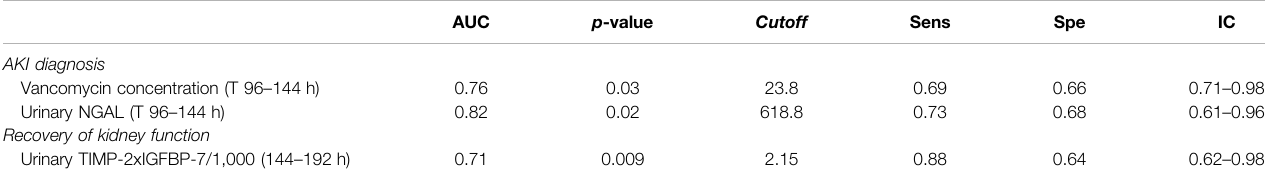
TABLE 9 | Sensitivity, speci fi city, area under curve, cutoff values of urinary biomarkers, and vancomycin concentration as predictors of diagnosis and recovery of kidney function in patients undergoing vancomycin and hospitalized in